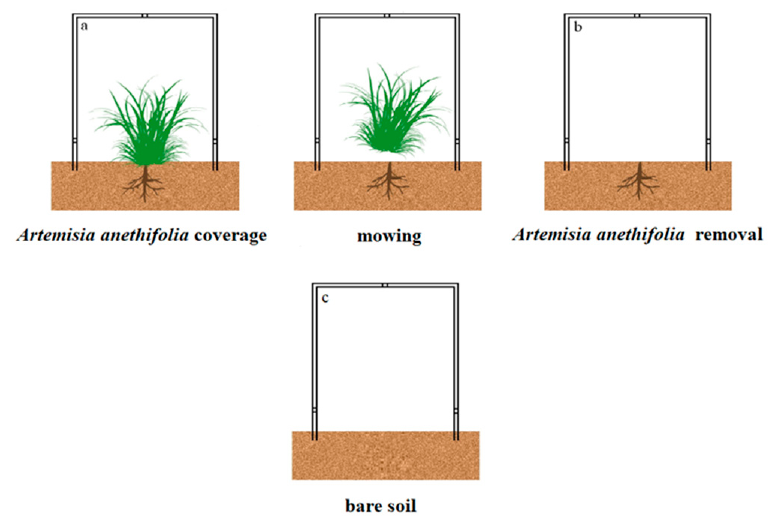
Figure 2. Schematic diagram of the experimental design: ( a , b ) Artemisia anethifolia coverage and removal; and ( c ) Bare soil.